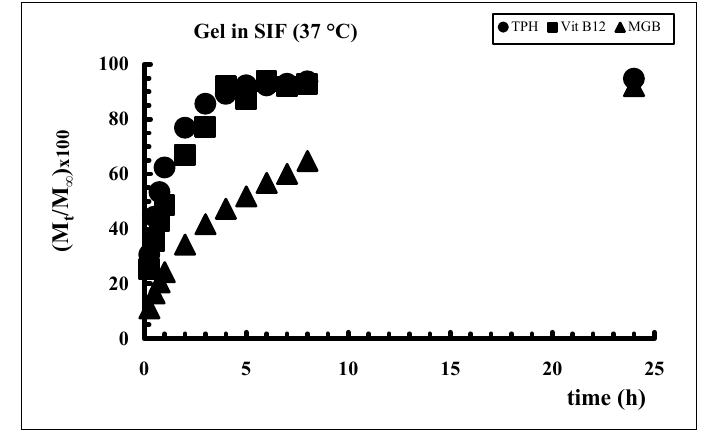
Figure 13. Release profiles of TPH, Vit. B12 and MGB from gel in Simulated Intestinal Fluid at 37 °C. Gel in SIF (37